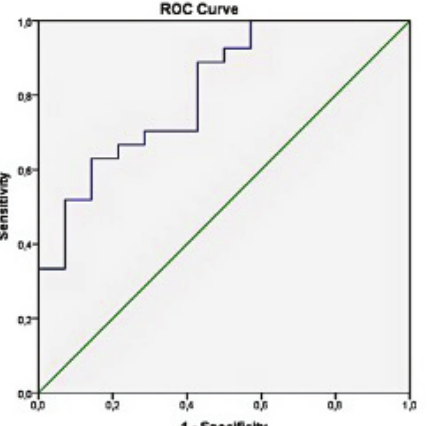
Figure 2 - mROX index ROC